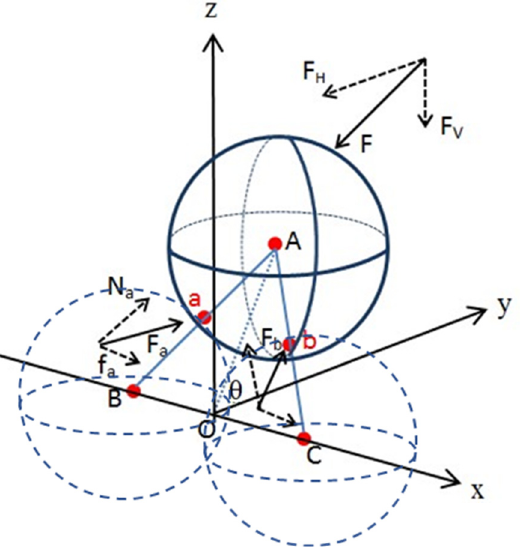
Figure 3. The applied forces on Ball A in the upper shear box in contact with Balls B and C at contact points a and b, respectively.